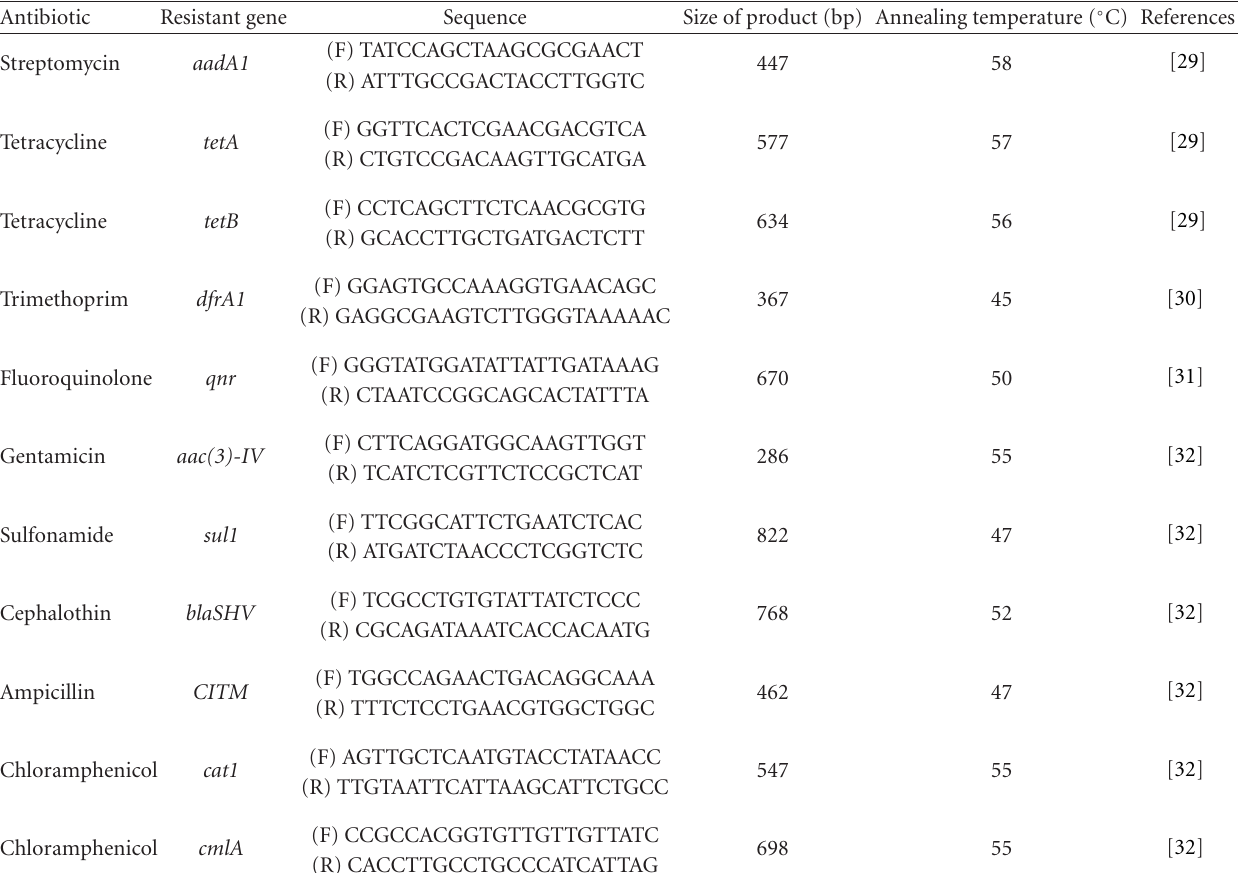
Table 3: Primers used for detection of antimicrobial resistant genes in Shiga toxin-producing Escherichia coli isolated from bovine mastitis.